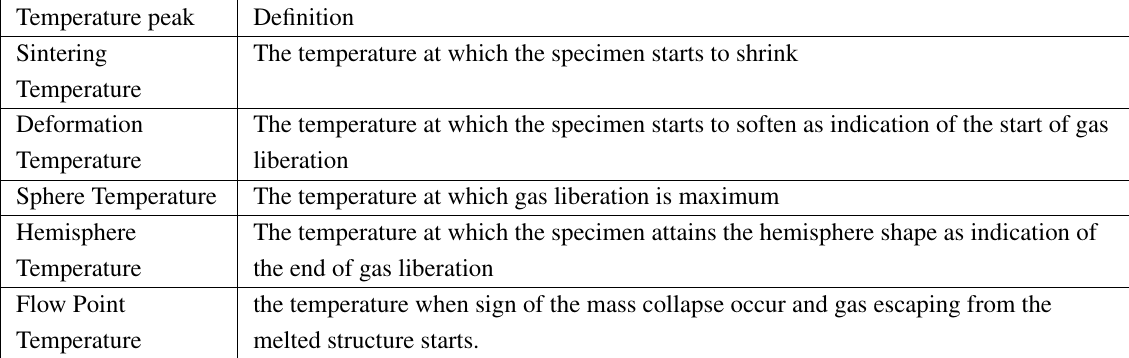
Table 4. Temperature peaks identified by